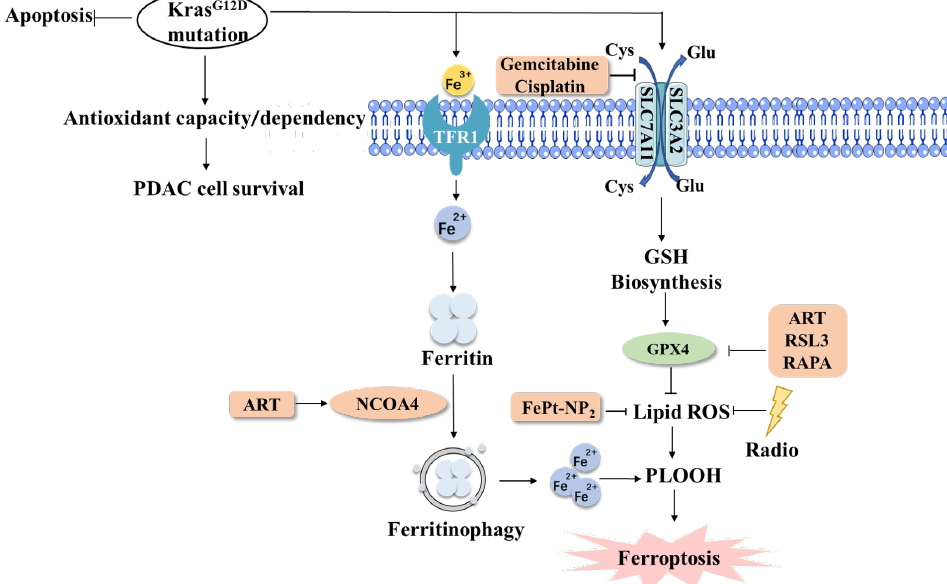
Figure 4. Ferroptosis in the treatment of PDAC. Kras G12D mutations can inhibit PDAC cell apoptosis by blocking ferroptosis. There are many therapeutic ways to cure PDAC by inducing ferroptosis in PDAC cells, such as targeted therapy, immunotherapy, nanomedicine, and radiotherapy. Abbrevi- ations: PDAC, pancreatic ductal adenocarcinoma.